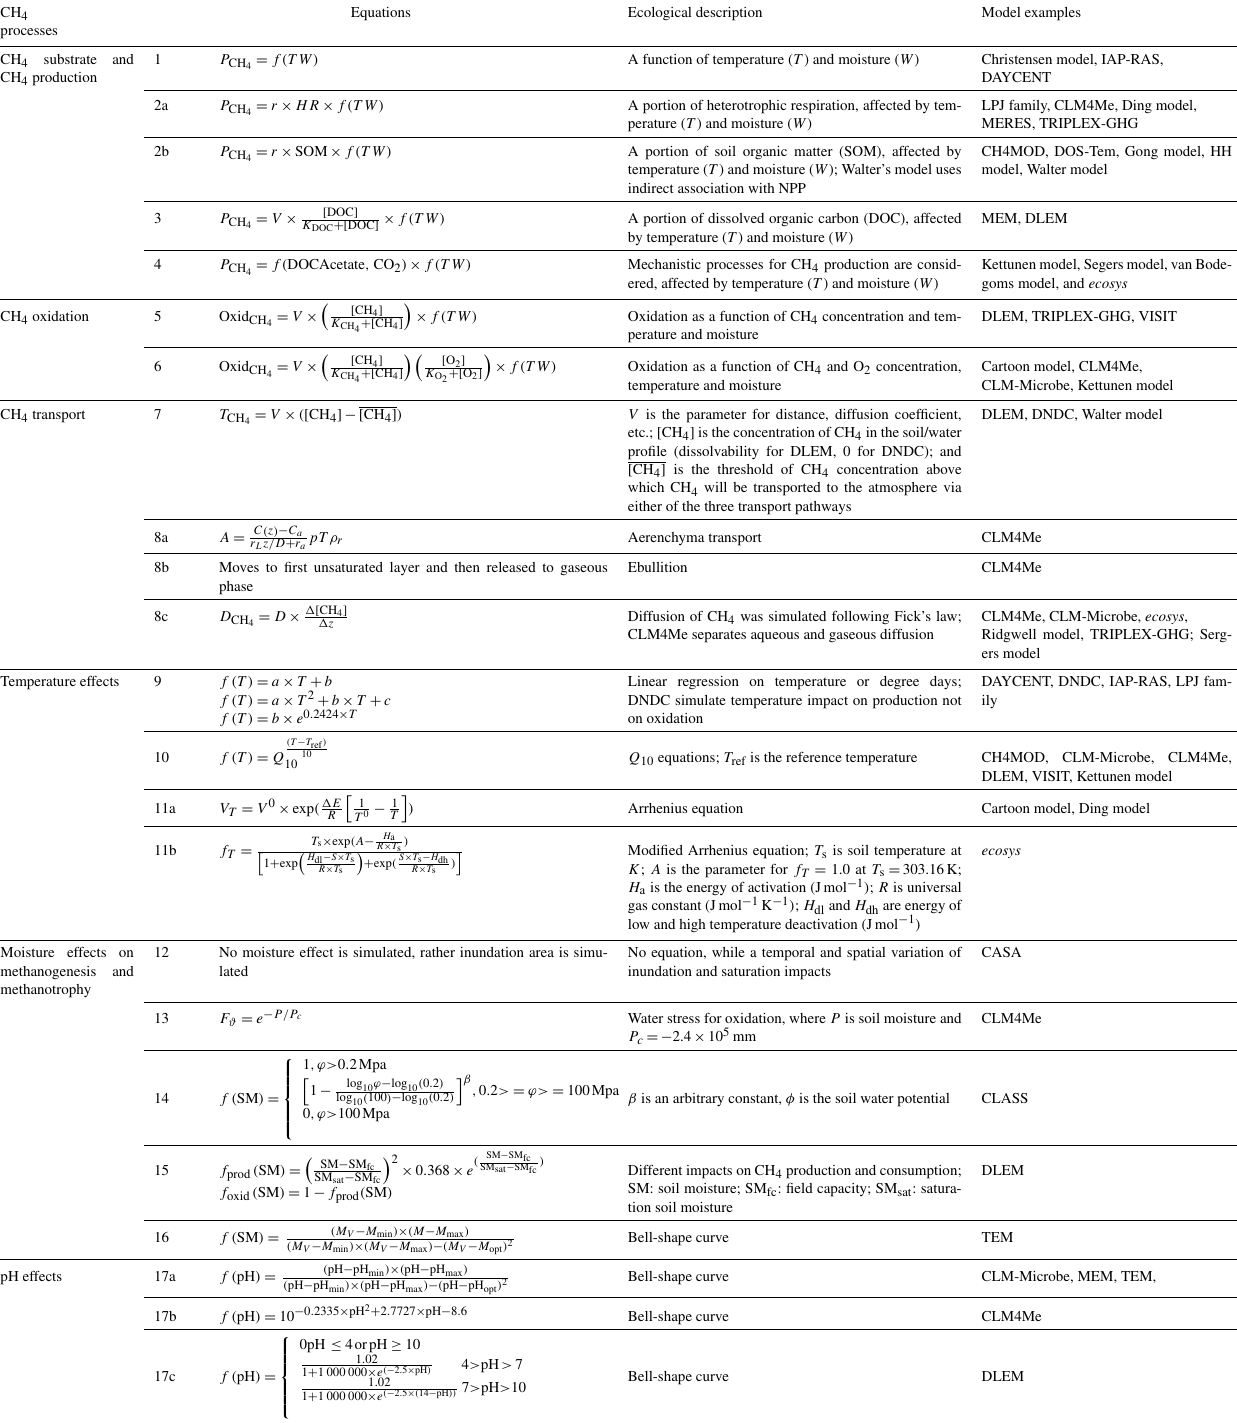
Table 3. The mathematical equations used to describe the CH 4 processes used in representative models ( P CH is the CH 4 diffusion rate; some parameters may have been changed is the CH 4 transport rate; D CH is the CH 4 oxidation rate; T CH Oxid CH 4 4 4 from the original publication to keep relative consistentcy in this